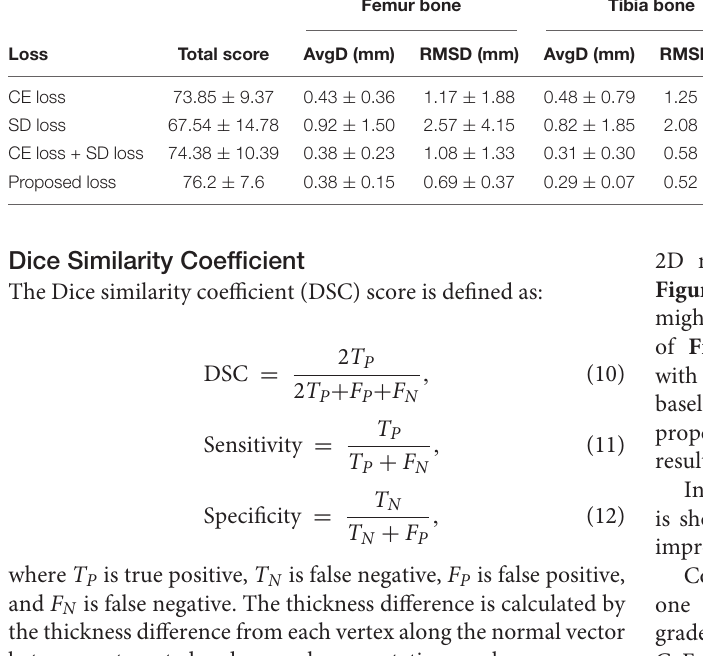
TABLE 3 | Results of the different loss functions based on the proposed network. Femur bone Tibia bone Femur cartilage Tibia